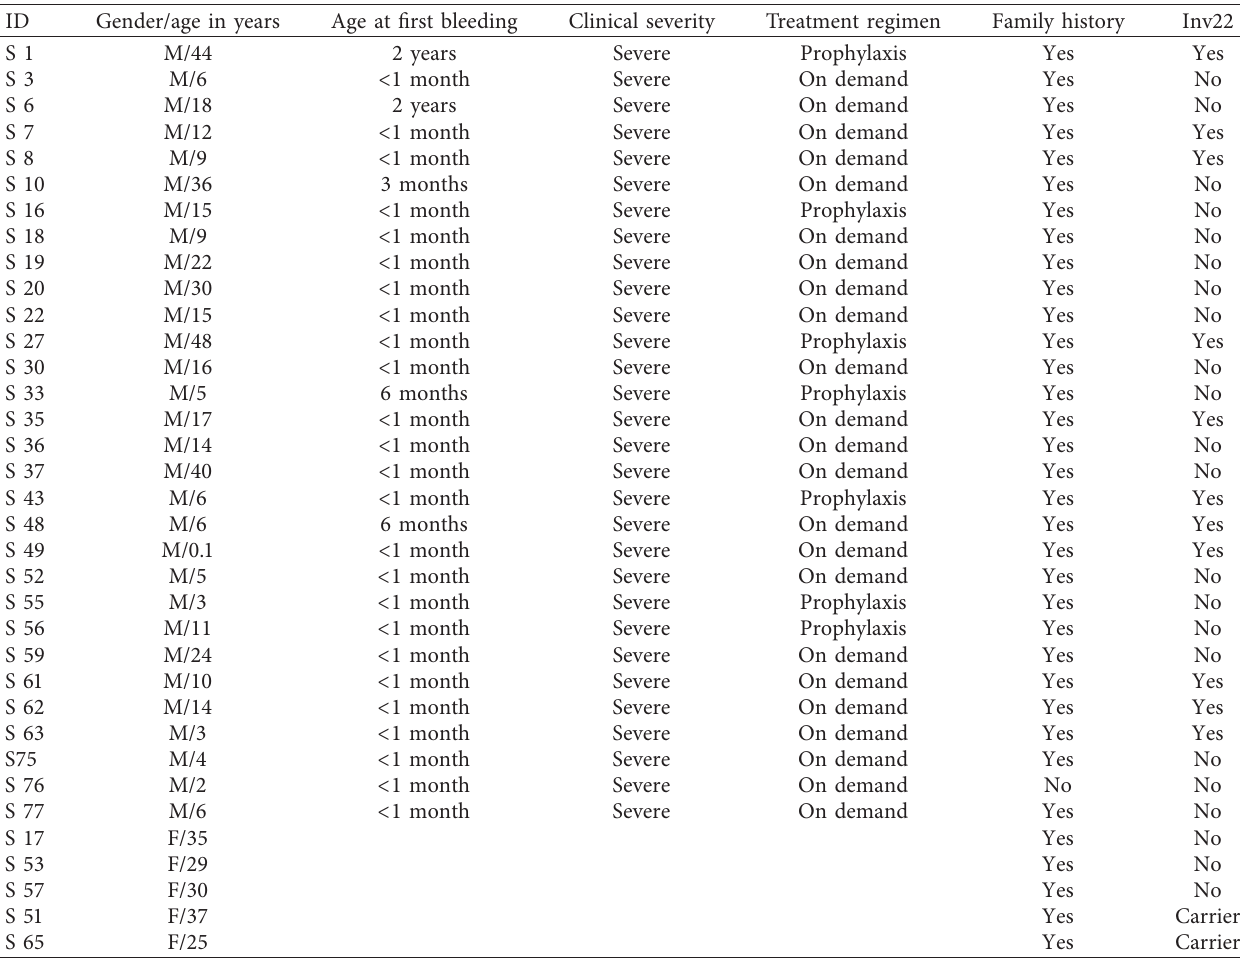
Table 2: Clinical and demographic data of severe HA patients from